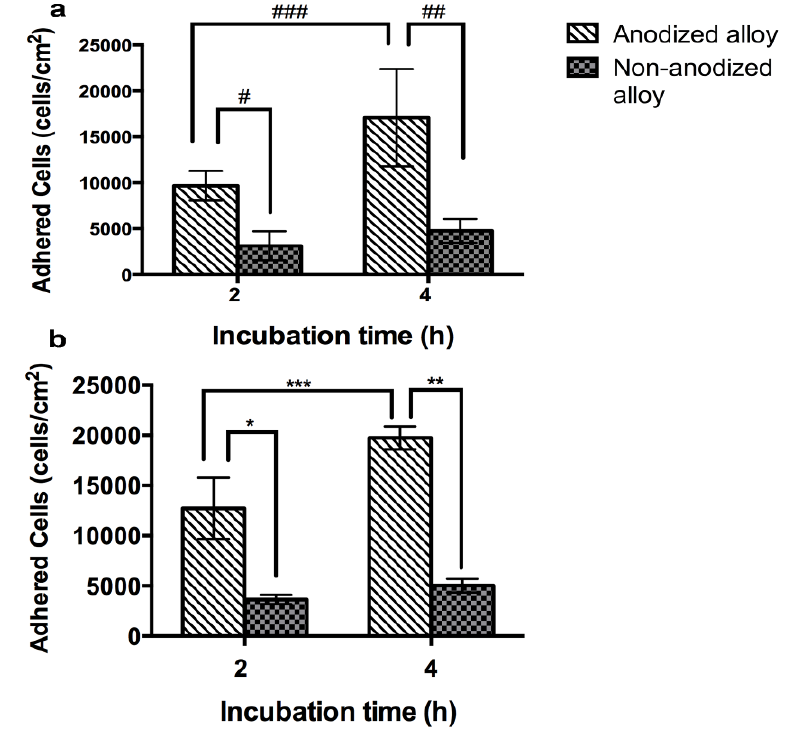
Figure 4. Cell counting using nuclei (DAPI) staining for PPO and PCC cells. ( a ) PPO and ( b ) PCC adhesion. (Values are the mean ± SD, n = 3; # p < 0.05 and * p < 0.05, significantly different from non-anodized Ti6Al4V alloy at 2 h of cell growth; ## p < 0.05 and ** p < 0.05, significantly different from non-anodized Ti6Al4V at 4 h of cell growth; ### p < 0.05 and *** p < 0.05, significantly different from anodized Ti6Al4V at 4